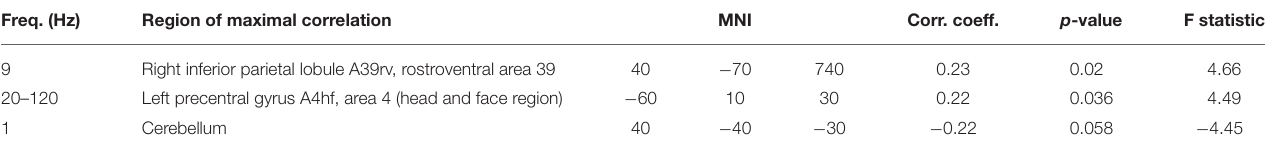
TABLE 5 | Clusters of brain activity correlating with rating of collaboration. Freq. (Hz) Region of maximal